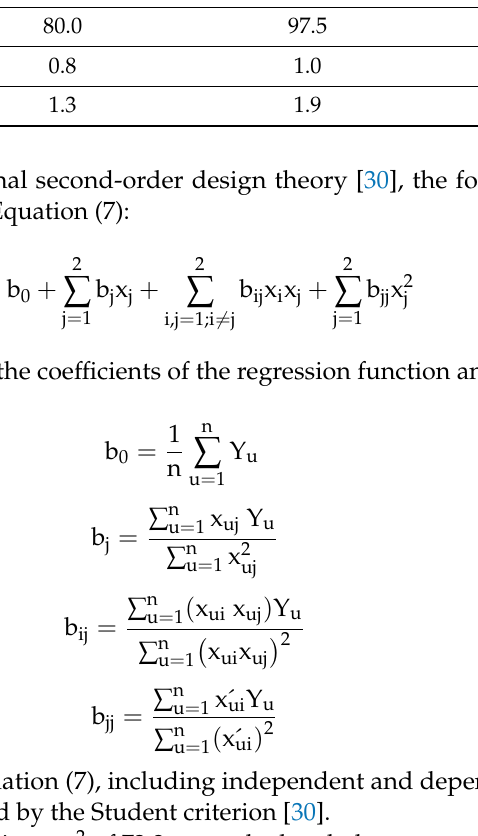
Table 4. Input parameters used in the research. Input